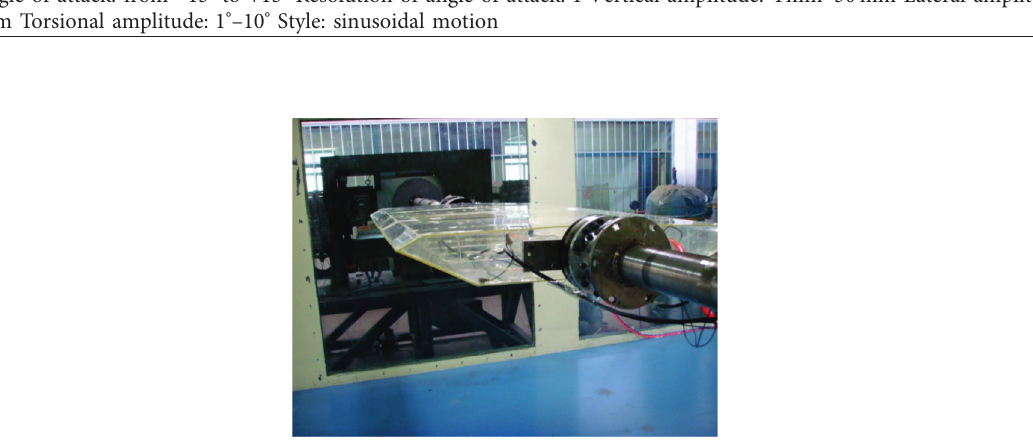
Figure 3: Section model and forced vibration system.